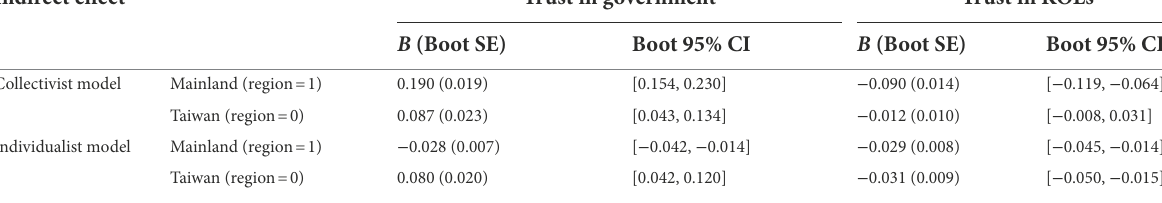
TABLE 4 Testing the conditional indirect effect on acceptance of the zero-COVID